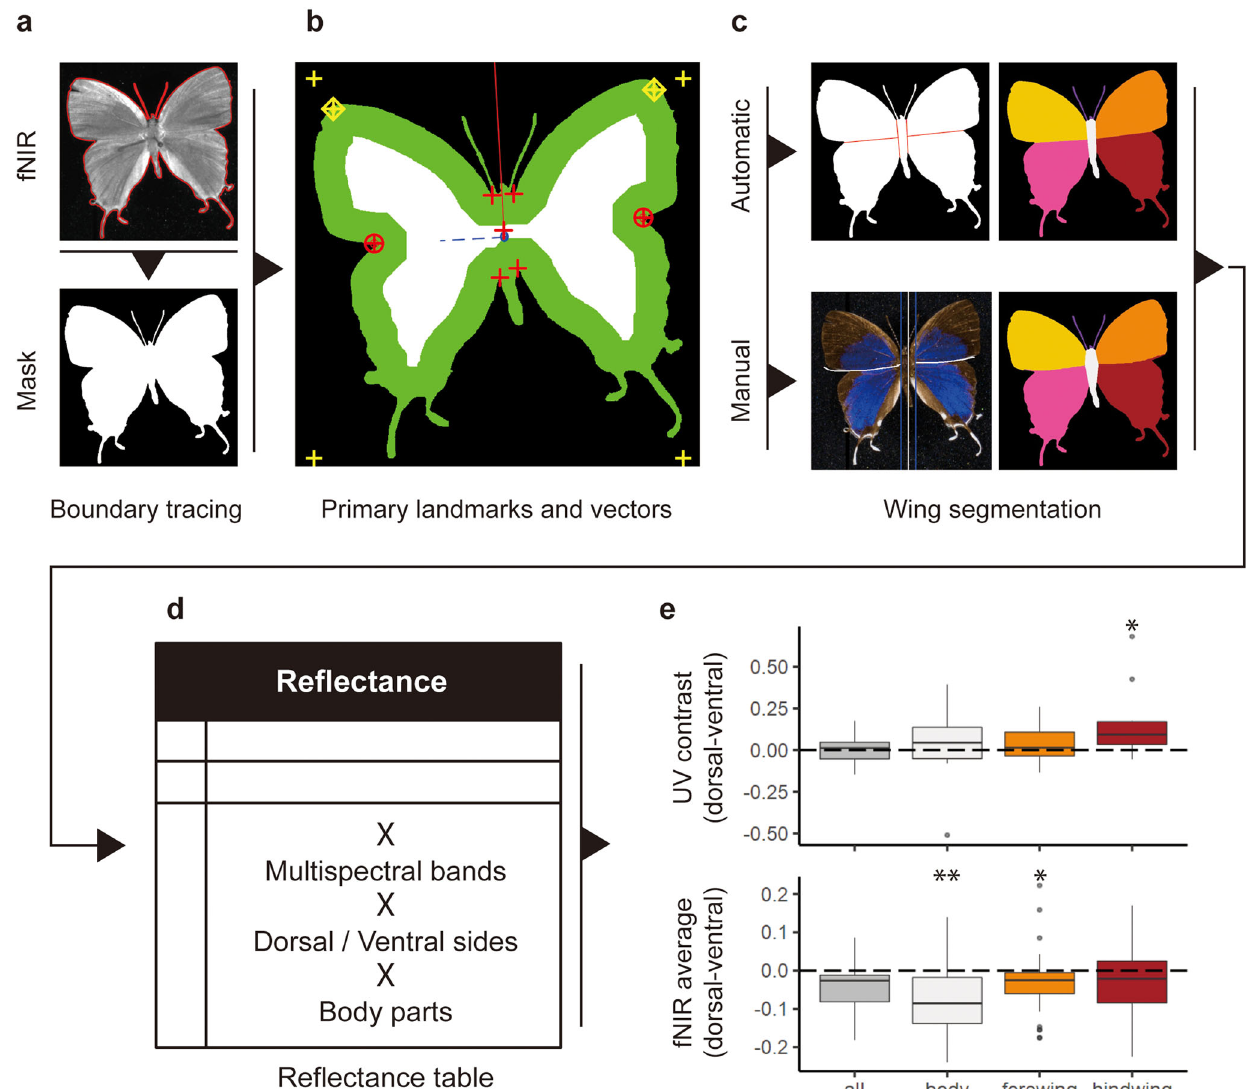
Fig. 9 Details of body part segmentation with preliminary observations. a Background removal based on fNIR image. b With primary landmarks (represented by crosses and circles) and vectors identifying the symmetrical axes (represented by segments in the solid red line and the blue dashed line), the specimen mask can be automatically segmented c With or without manually de fi ned fore-hindwing division of the overlap region. The species shown in ( a – c ) is Oxylides faunus . d Statistical summary (mean, variation, and patch size) of all bands for both sides (dorsal and ventral) of all body parts (four wings and the body) can be calculated. e Statistical results of exemplar bands based on 17 specimens from 7 different families. Center line represents median; box limits, upper and lower quartiles; whiskers, 1.5x interquartile range; points, outliers. Statistically signi fi cant levels of difference between dorsal and ventral sides (under two-tailed t-test) are labeled by asterisks: *, 0.05; **.